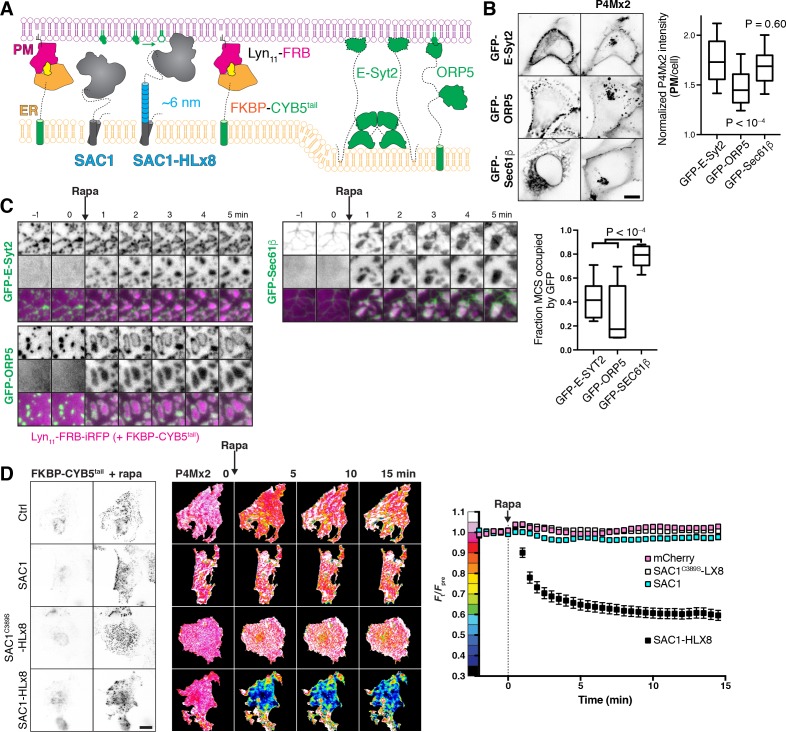
An extended helical linker is required for ‘trans’ activity of SAC1 at induced ER-PM MCS.(A) Induction of artificial ER-PM MCS using rapamycin-induced dimerization of PM Lyn11-FRB and ER FKBP-CYB5Atail. (B) Over-expression of E-Syt2 does not deplete PtdIns4P. COS-7 cells over-expressing GFP-tagged E-Syt2, ORP5 along with mCherry-P4M × 2; scale bar = 10 µm. Graph shows P4M intensity at the plasma membrane (defined by CellMask deep red dye) normalized to total cell intensity; box and whisker plot shows quartiles and 5–95 percentiles of 89–90 cells from three independent experiments. P values derive from Dunn’s multiple comparison test compared to Ctrl after a Kruskal-Wallis test (p<10–4). (C) FKBP-CYB5tail induces narrower contact sites than those occupied by E-Syt2 or ORP5. COS-7 cells expressing the indicated GFP-fusion protein, Lyn11-FRB-iRFP or mCherry-FKBP-CYB5tail (not shown), dimerization induced with Rapa as indicated. Graph shows the fraction of induced contact sites occupied by GFP-fluorescence after 5 min of rapa treatment; box and whisker plot shows quartiles and 5–95 percentiles of 14–19 cells from four independent experiments. P values derive from Dunn’s multiple comparison test compared to Ctrl after a Kruskal-Wallis test (p<10–4). (D) An extended helical linker is required for robust ‘trans’ activity of SAC1 at ER-PM MCS. Images of TagBFP2-tagged FKBP-CYB5 and GFP-P4M × 2 in COS-7 cells co-transfected with iRFP-tagged Lyn11-FRB and the indicated mCherry-tagged SAC1 construct, or mCherry alone as control. Images of GFP-P4M × 2 are normalized to the mean pre-stimulation pixel intensity, that is Ft/Fpre with the color coding reflected in the graph y-axis. Scale bar = 20 µm. Graphs show the fluorescence intensity of GFP-P4M × 2 in the TIRF footprint of each cell (means ± s.e., 29–30 cells from three independent experiments) normalized to the mean pre-stimulation level (Fpre).10.7554/eLife.35588.023Figure 6—source data 1.Data for panel 6B.10.7554/eLife.35588.024Figure 6—source data 2.Data for panel 6C.10.7554/eLife.35588.025Figure 6—source data 3.Data for panel 6D.